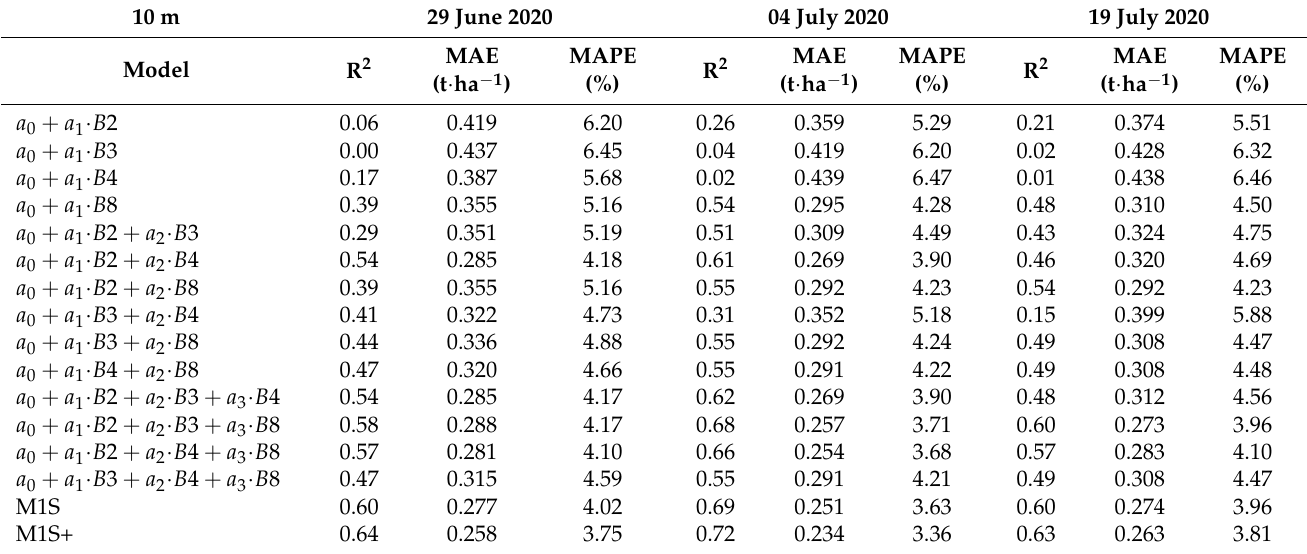
Table A1. JSendra 10 m spatial resolution model evaluation with training data (model coefficients are different for each equation).